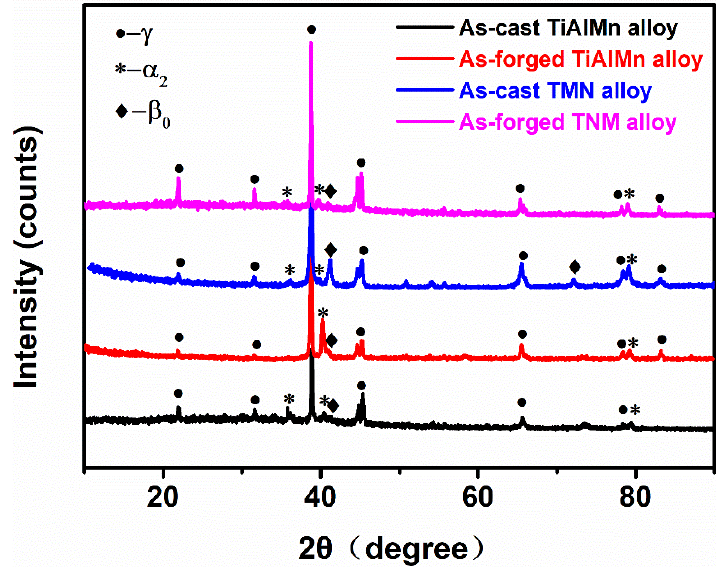
Figure 3. XRD patterns of as-cast and as-forged TiAlMn and TNM alloys.